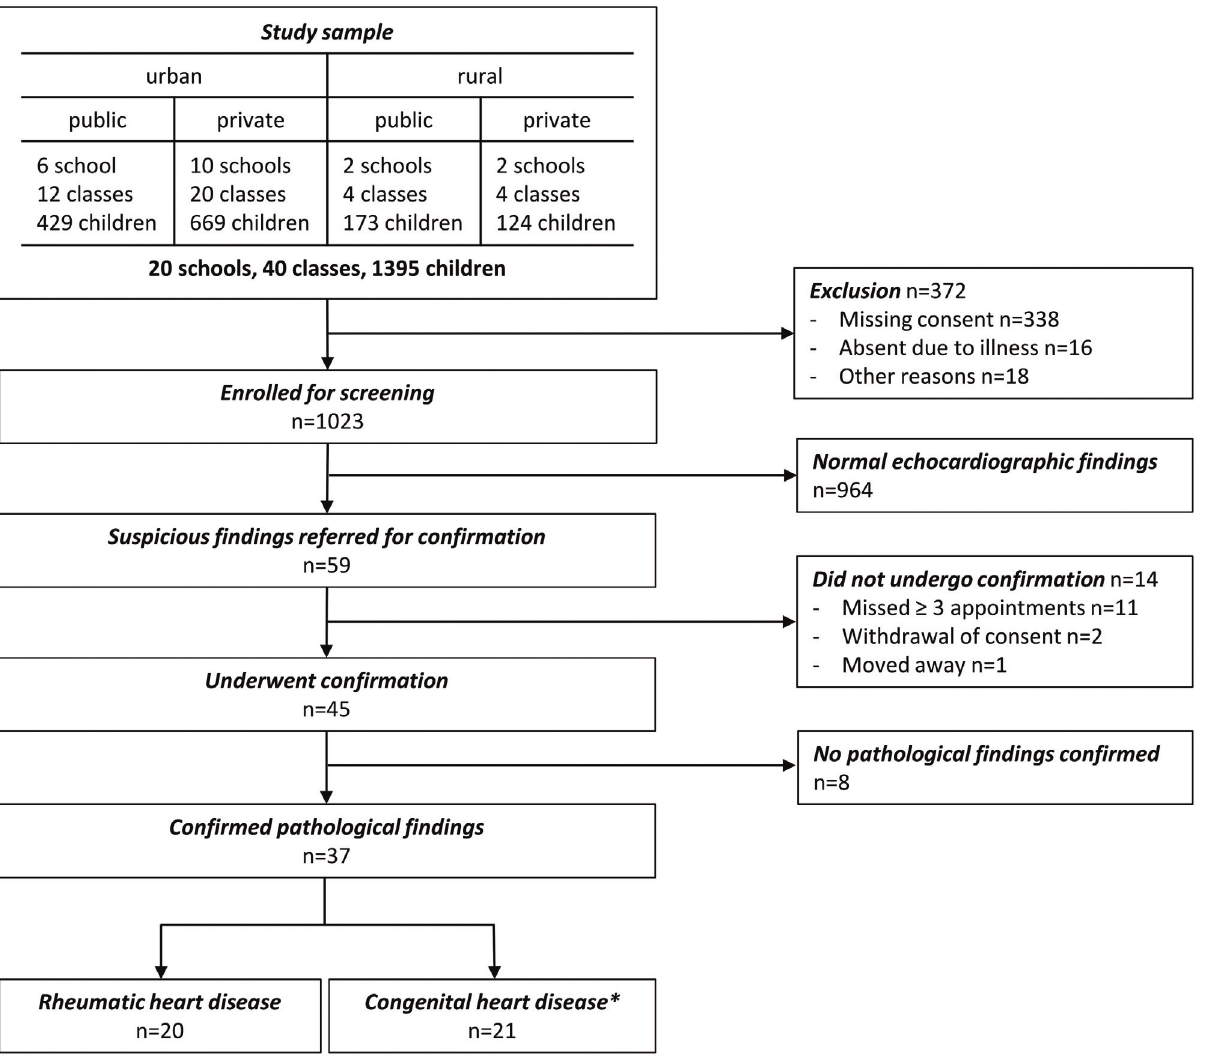
Fig 1. Patient flow according to STROBE statement. * 4 children had both rheumatic heart disease and congenital heart